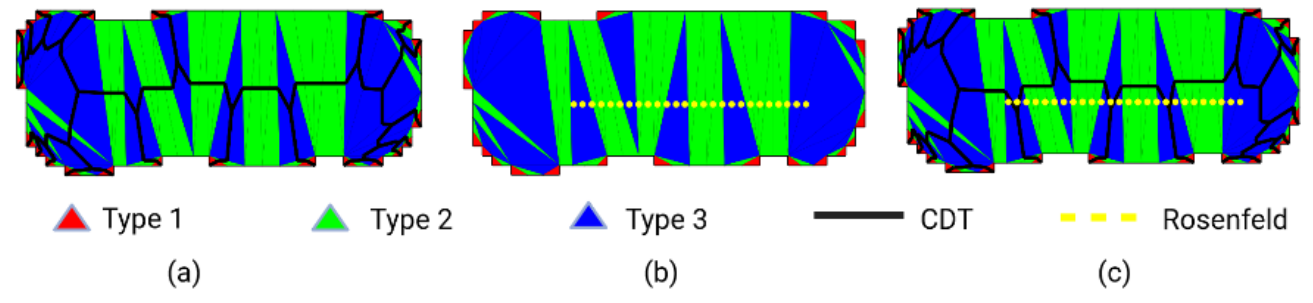
Figure 4. Skeleton line extraction results. ( a ) CDT; ( b ) Rosenfeld; ( c ) Overlap of CDT and Rosenfeld